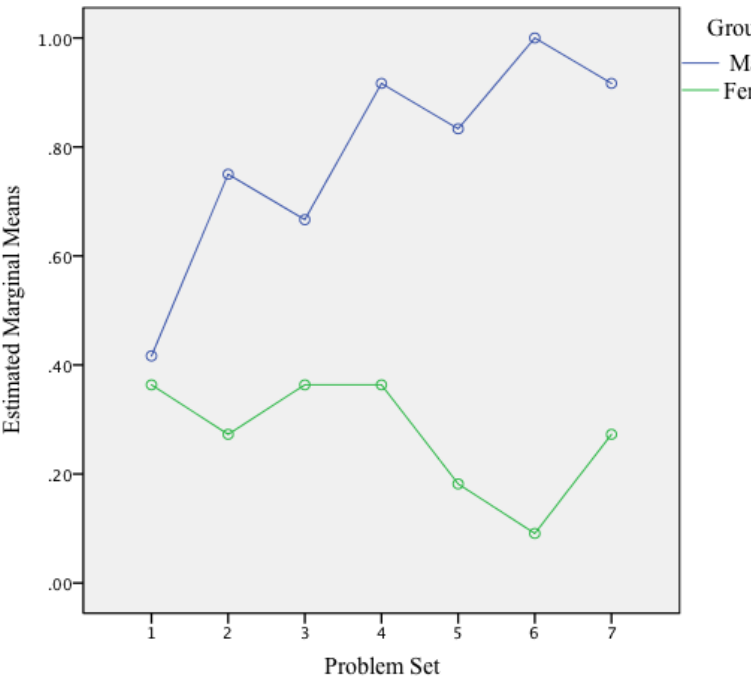
Figure 3. Average correct use of retrieval and cognitive strategies in